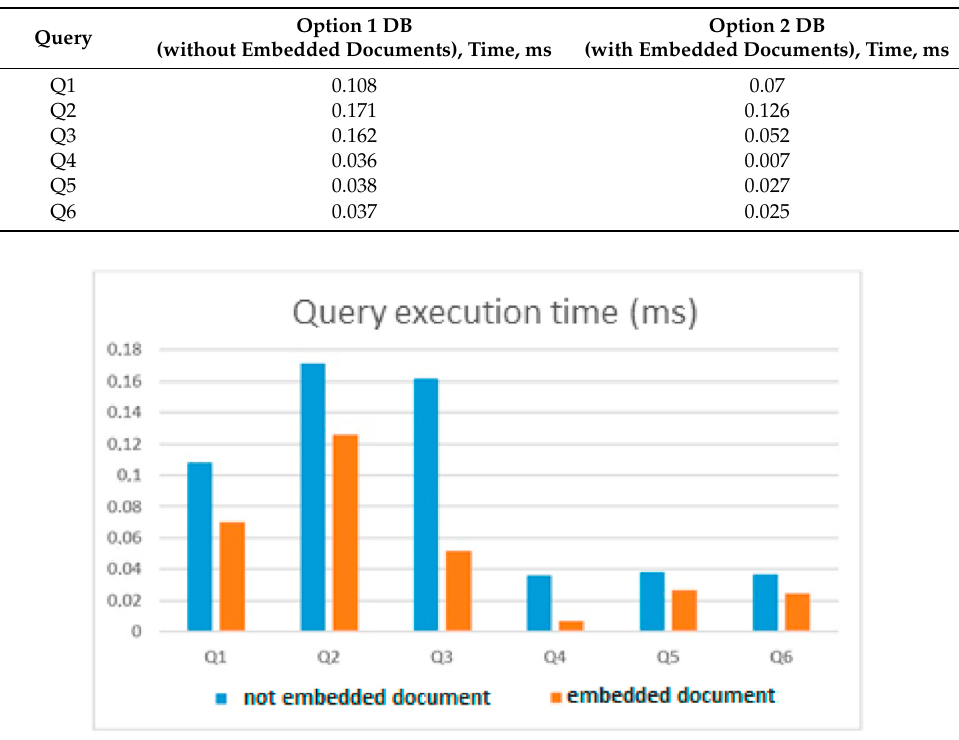
Figure 10. A diagram showing the execution time of six queries to a database of two types: a single database and a database with embedded documents.